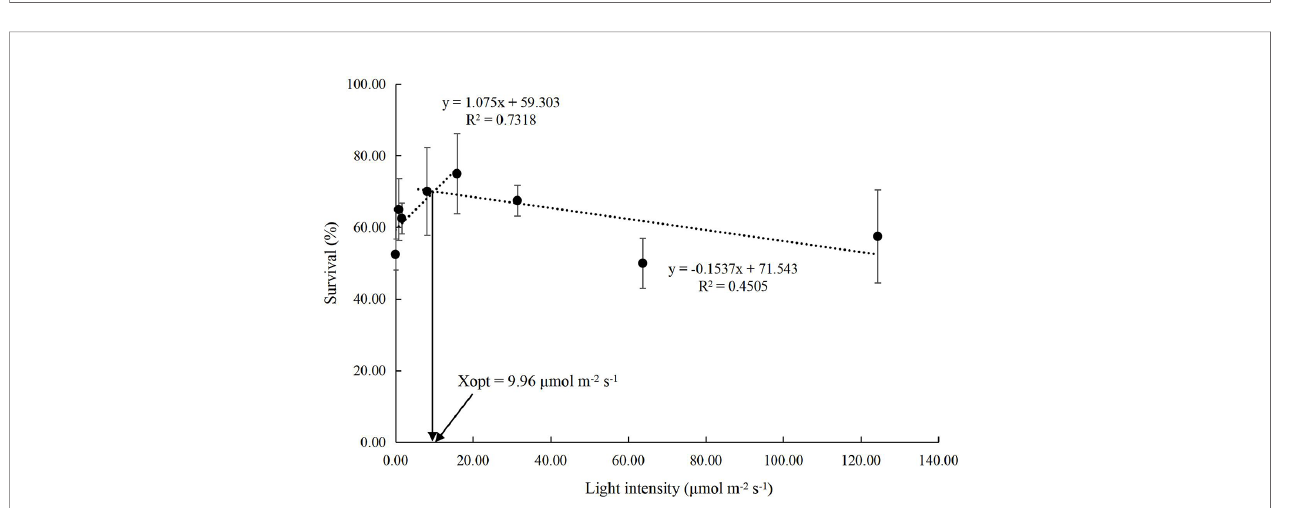
FIGURE 2 | Effect of different light intensities on the weight gain (WG) and molting frequency (MF) of juvenile Portunus trituberculatus (mean ± SD, n = 4). Different lowercase and capital letters indicate signi fi cant differences ( P < 0.05) in WG and MF,